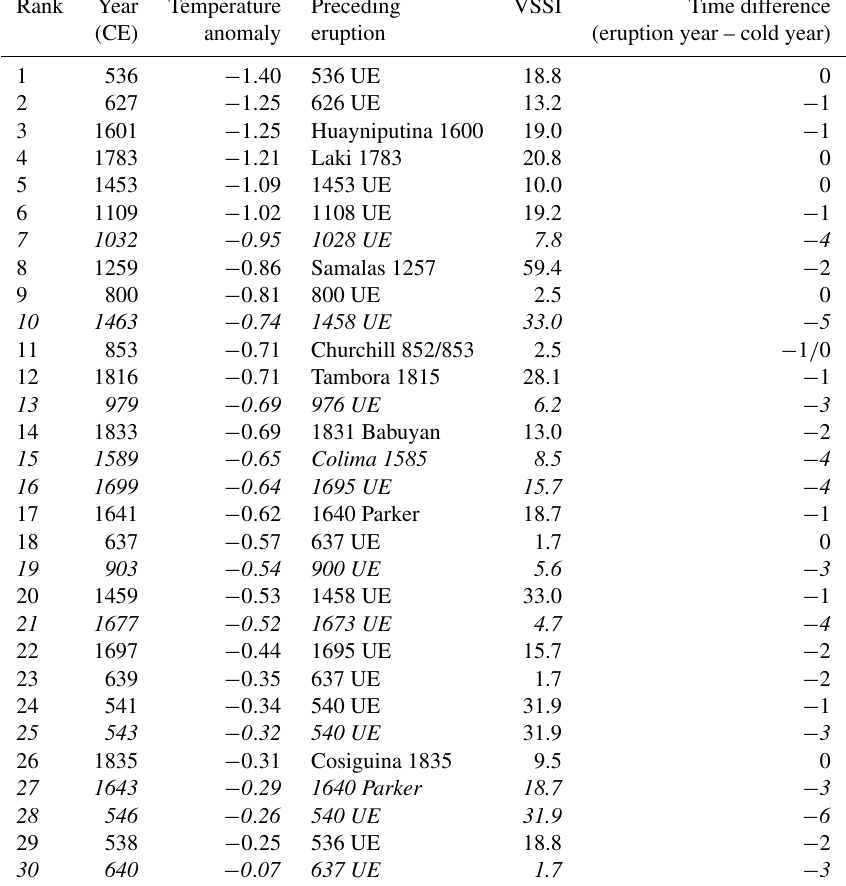
Table G1. Top 30 coldest years during the period of 500–2000CE based on tree-ring temperature anomalies filtered using a 3-year mean and corresponding eruption information for proximal calendar years. Eruption dates and volcanic stratospheric sulfate injection (VSSI) estimates taken from the eVolv2k reconstruction (Toohey and Sigl, 2017), representing the most immediate preceding eruption in the dataset. Roman font: eruption occurred within 2 years of the coldest reported year; italic font: eruption occurred more than 2 years before the coldest reported year. Unidentified eruption: